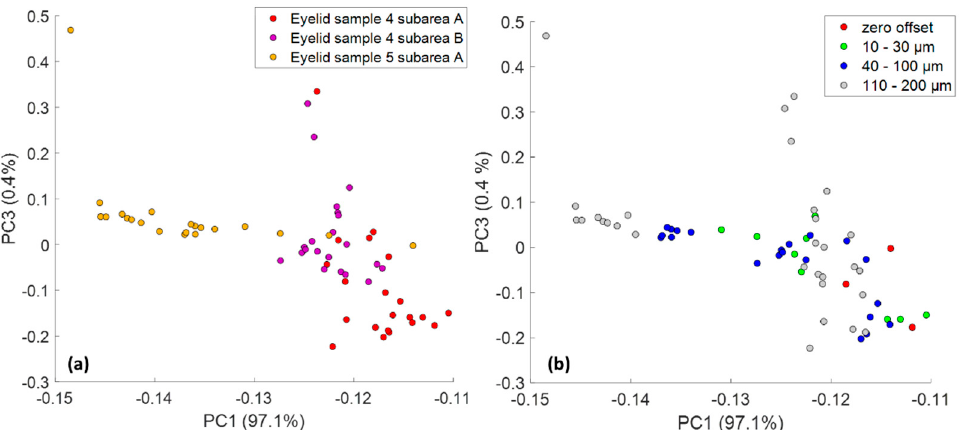
Figure 7. PCA scatter plots for Raman spectra collected from eyelid skin of ( a ) different sample areas and donors and ( b ) different offsets.